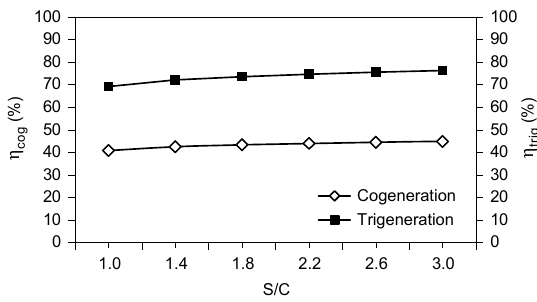
Figure 3. System cogeneration and trigeneration average efficiencies as a function of the S/C .